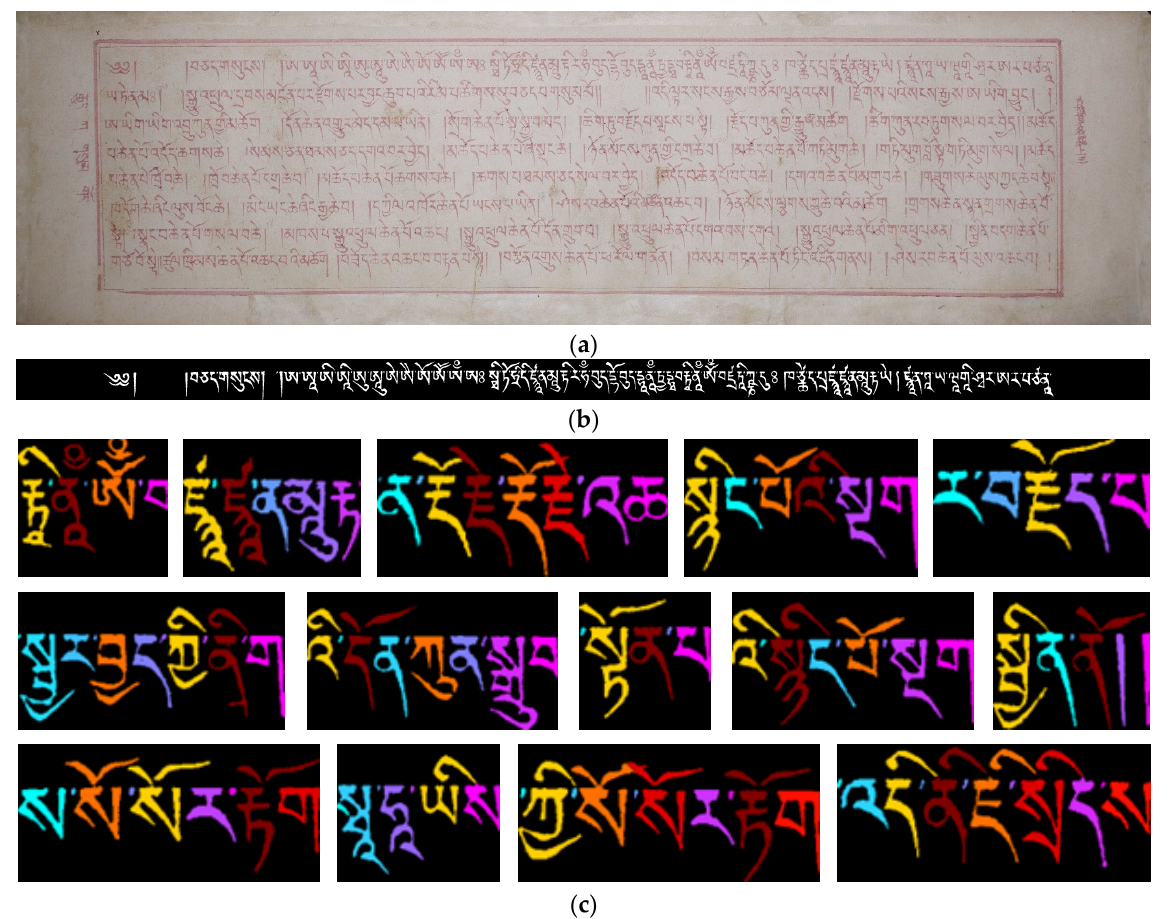
Figure 1. The research basis of this work: ( a ) example of historical Uchen Tibetan document; ( b ) example of text line after binarization and extraction; ( c ) partial character block obtained after a series of processes.